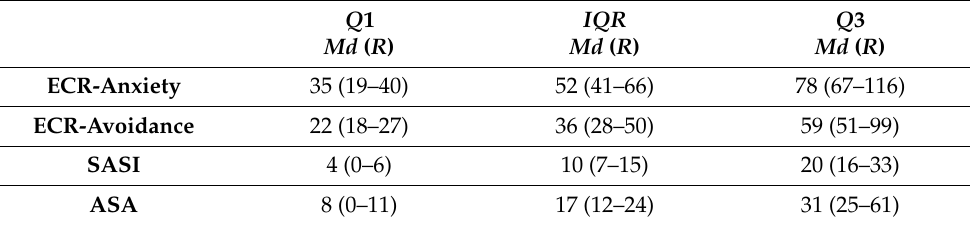
Table 1. Variables’ median and values range within each